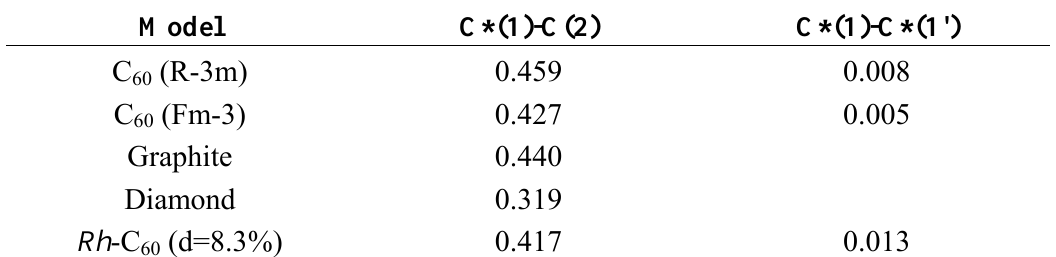
Table 1 Mulliken bond populations of several C-C bonds calculated by the B3LYP method.